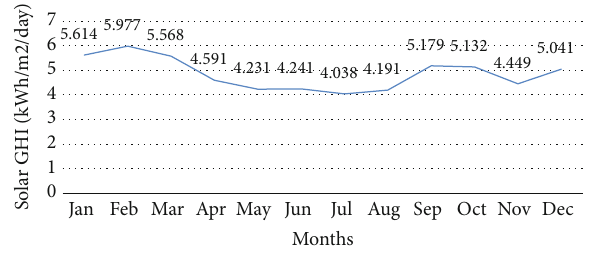
Figure 25: Monthly solar Global Horizontal Irradiation (GHI kWh/m 2 /day) for Tanzania.